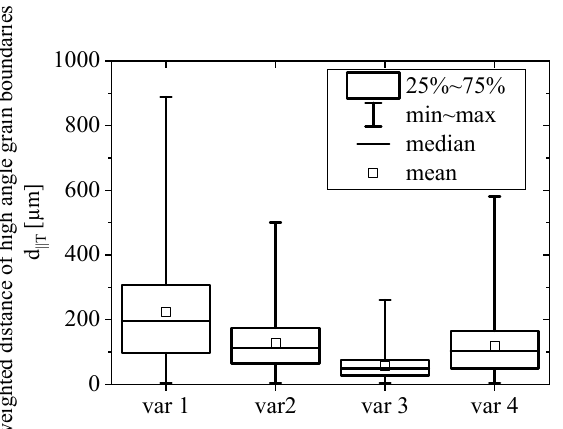
Figure 4. Distance between high angle grain boundaries (>15°) in T direction. The box plot was achieved via a weighting procedure taking the grain sizes into account.